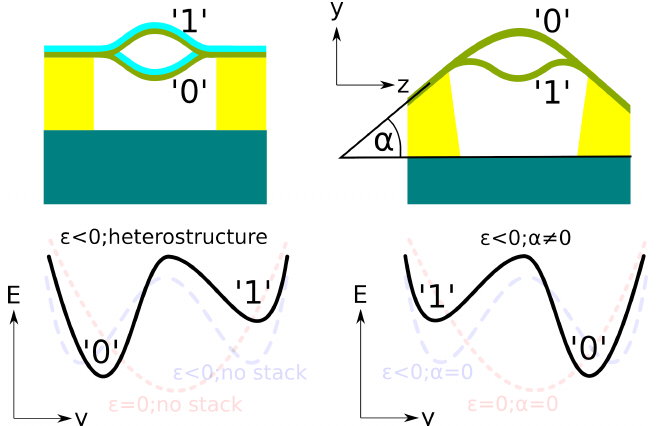
Figure 3. Scheme of the proposed architectures. Top panels show a schematic of the architectures where yellow blocks represent the gold electrodes where the structure is attached to. Lower panels shows a pictoric representation of the energy landscape of the structure as a function of the maximum out-of-plane displacement y